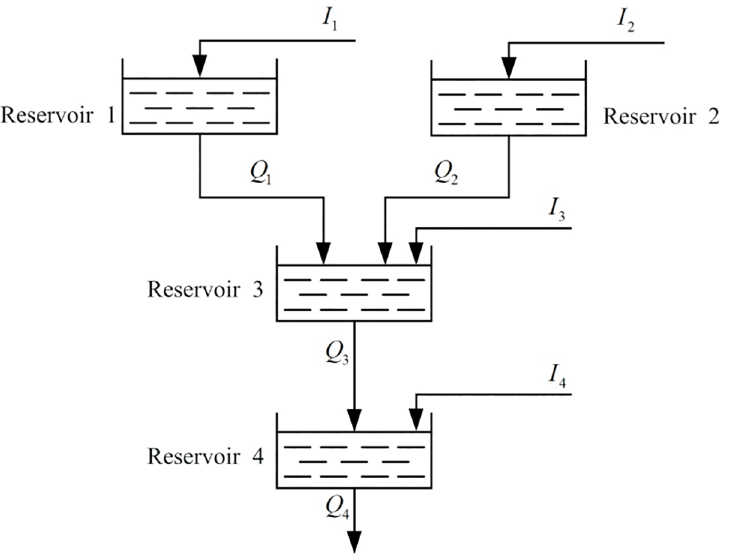
Fig 3. The network of hydraulic system.